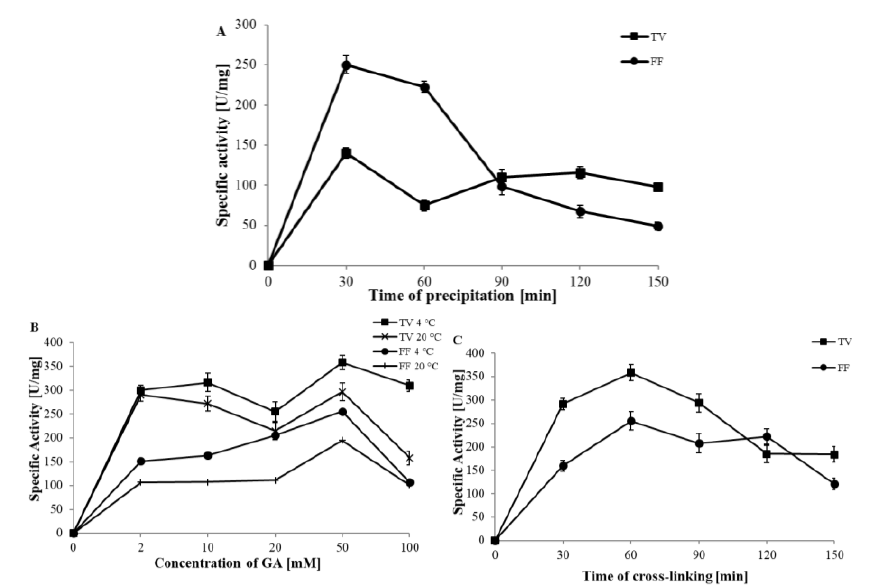
Figure 1. ( A ) Precipitation of laccases at different times using 75 wt.% ammonium sulphate; ( B ) Concentration and temperature of glutaraldehyde for cross-linking procedure; ( C ) Time of cross-linking using 50 mM GA and 4 °C.